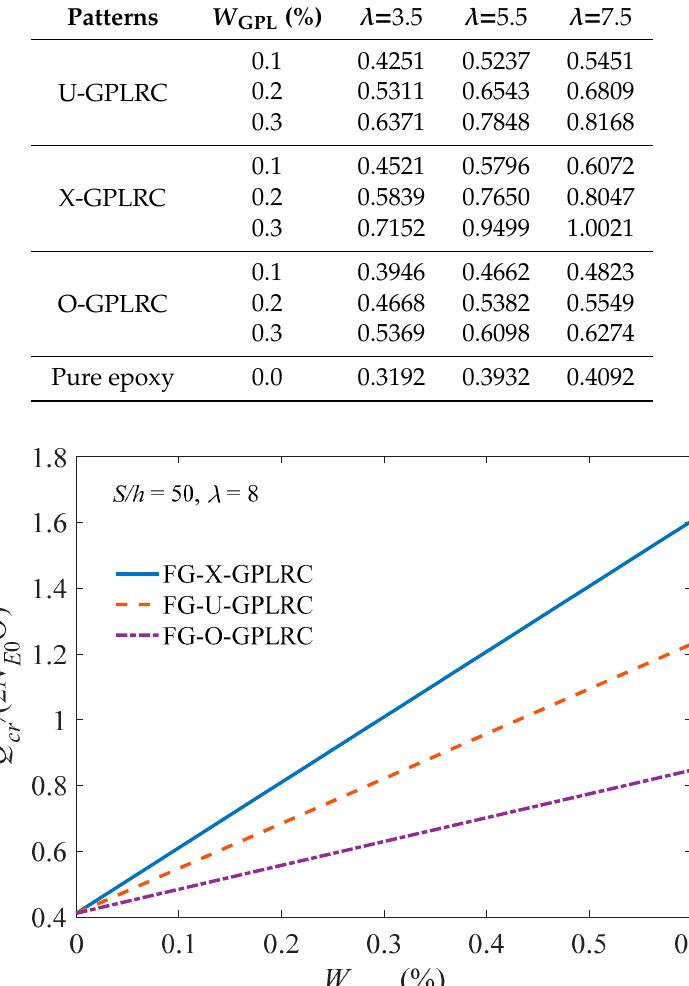
Figure 6. E ff ect of GPL weight fraction on buckling loads of the FG-GPLRC Figure 6. Effect of GPL weight fraction on buckling loads of the FG-GPLRC arch. Table 2. Limit point buckling load of FG-GPLRC arches.